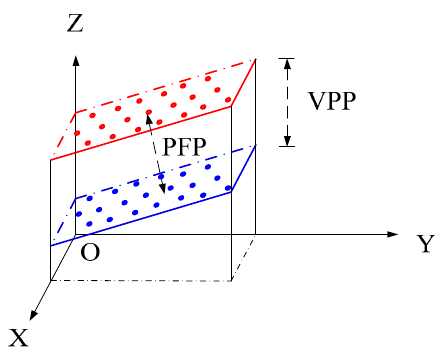
Figure 4. Schematic diagram of VPP distance and PFP distance. The blue segment indicate an old roof in the ALS data. The red segment indicate a new roof in the DIM data. The height of the inclined roof has increased.